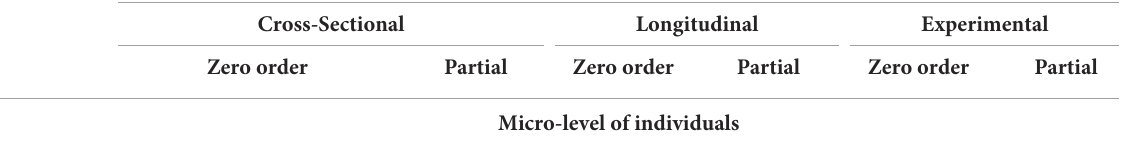
TABLE 2 171 findings on the relation between perceived meaning of life and satisfaction with life. Aspects of perceived meaning in